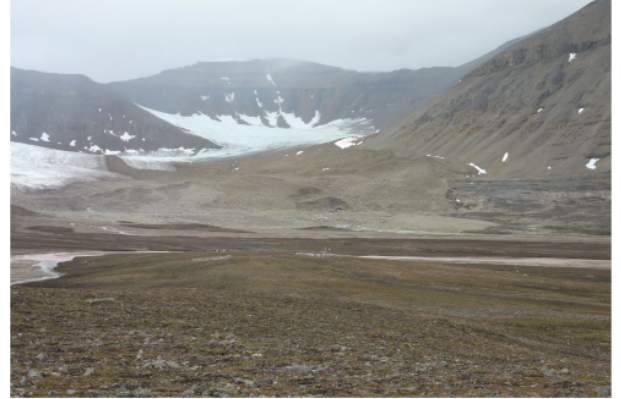
Fig. 2. View over the Bayelva catchment area.